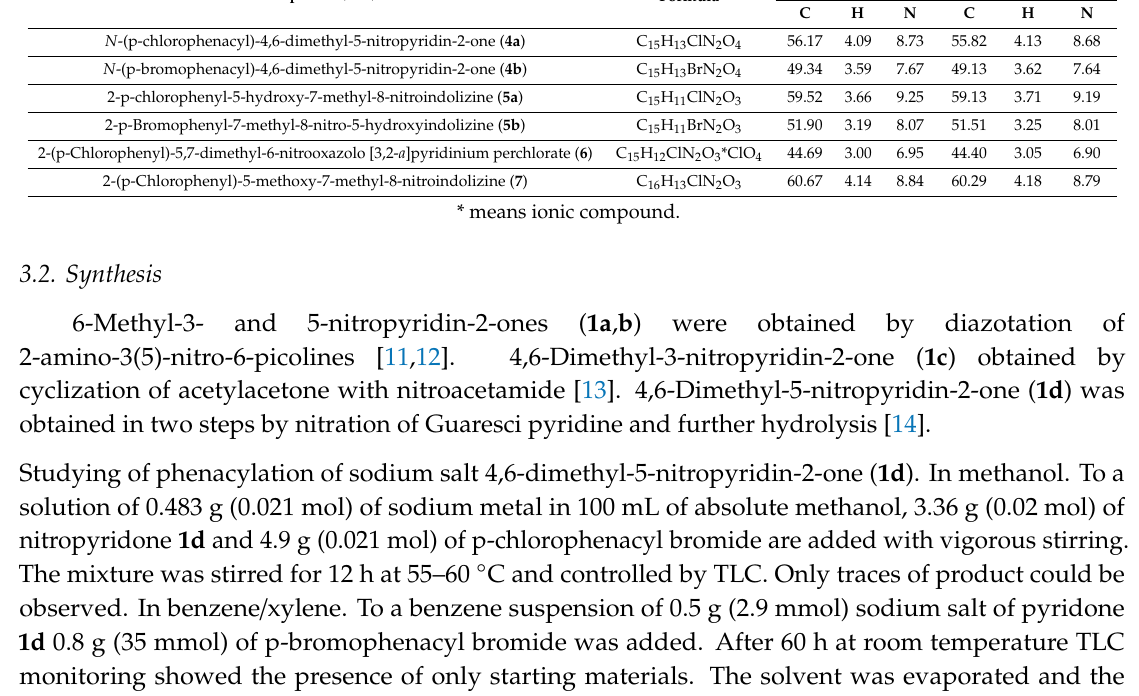
Table 2. Elementary analysis data for all new compounds. Compound